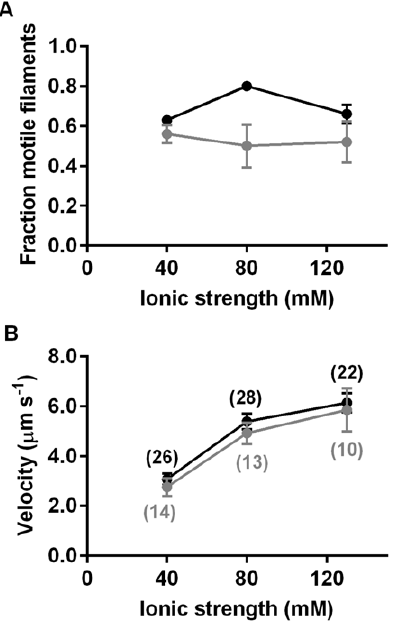
Figure 2. Motility quality for biotinylated actin filaments with 1–2 quantum dot cargoes attached along the filaments. A. Fraction of motile filaments in the absence (black) and presence (grey) of quantum dots. Error bars represent SEM. B. Sliding velocity for biotinylated F-actin without (black) and with (grey) quantum dots. Error bars represent 95% confidence intervals. Number of filaments given in parentheses.